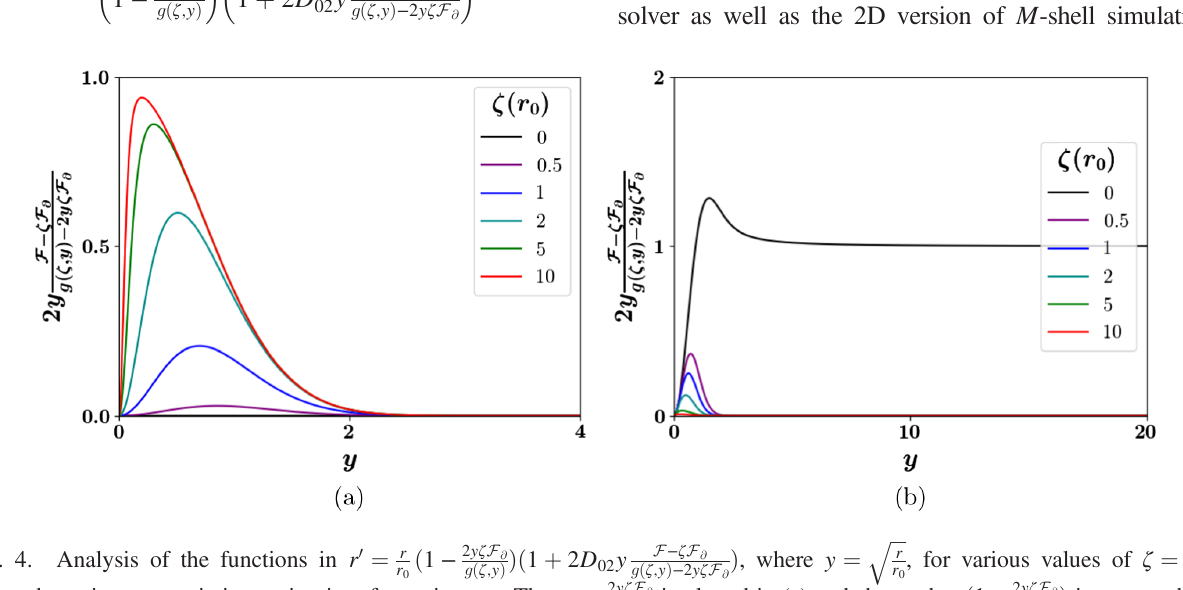
FIG. 4. Analysis of the functions in r 0 ¼ r Notice that y is monotonic increasing in r for a given r 0 . The term 2 y ζ F ∂ for y > 0 . The term 2